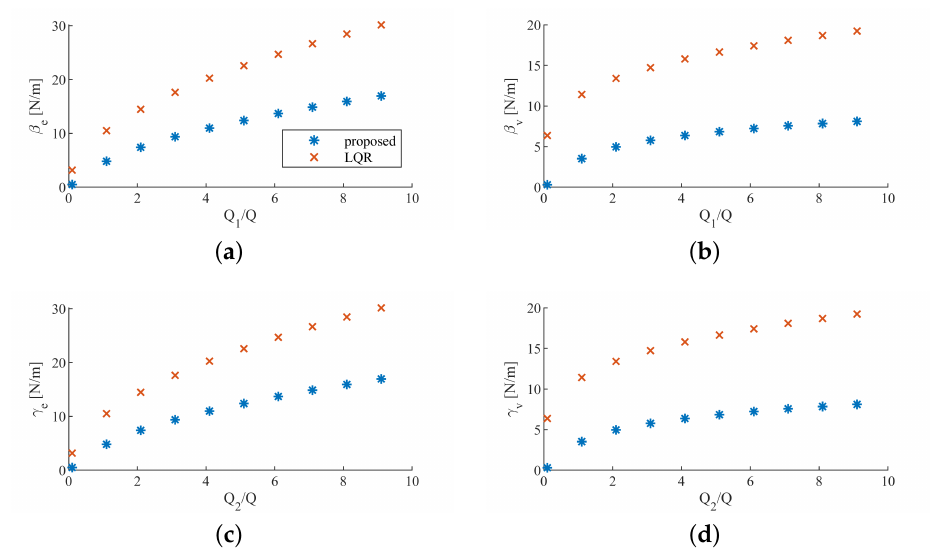
Figure 7. Control gains for different values of humans’ state weights. ( a ) and ( b ) the state weight of the human 1 vary. ( c ) and ( d ) the state weight of the human 2 vary.